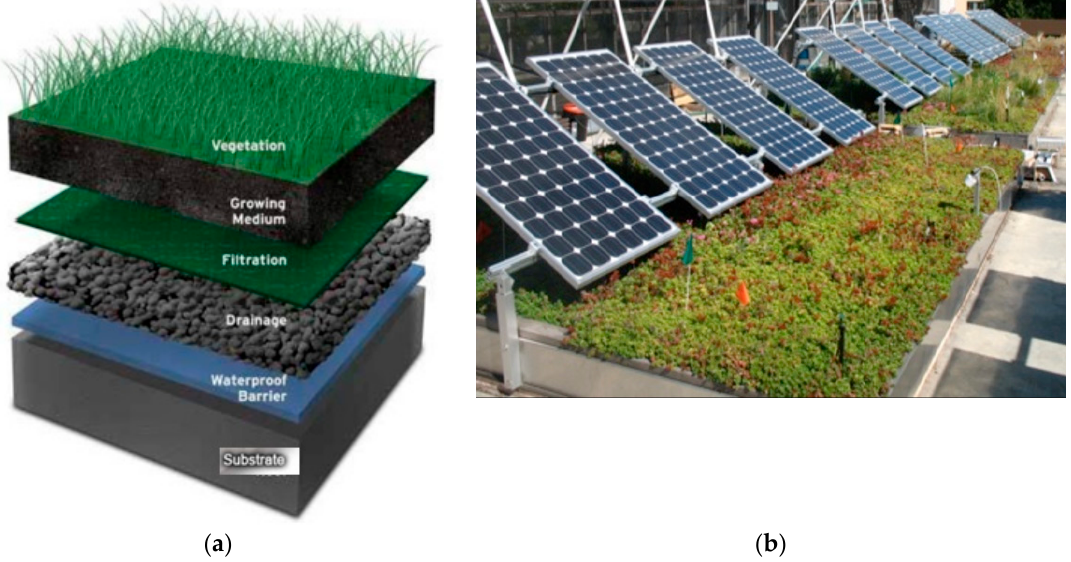
Figure 1. The structure of a green roof ( a ); and green roof mounted with rooftop solar photovoltaic (PV) systems ( b ).